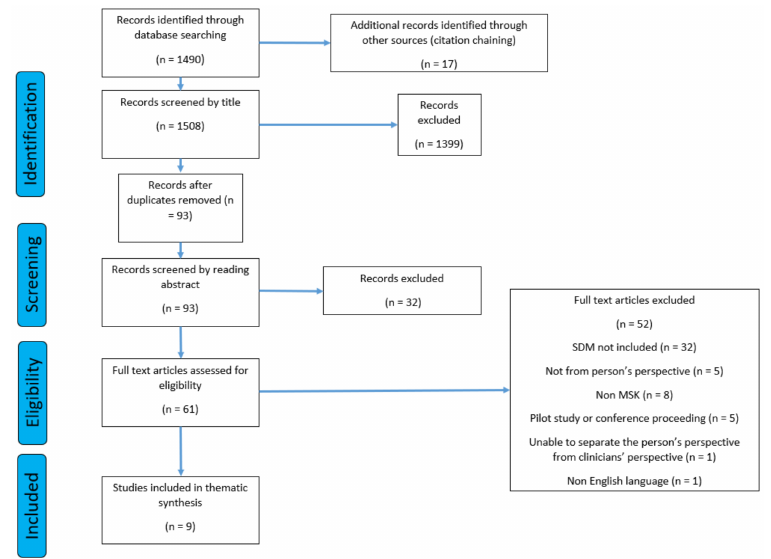
Figure 1. The PRISMA flow